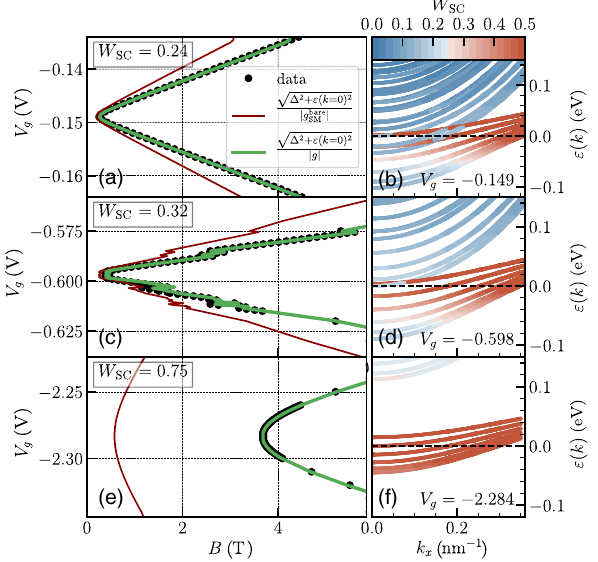
FIG. 13. Phase diagram (a),(c),(e) and band structure (b),(d),(f) in the vicinity of threshold gate voltages, corresponding to the − 0 . 15 (a),(b); V change in the number of subbands: V g ¼ g ¼ − 0 . 6 (c),(d); V − 2 . 3 (e),(f). Black dots in the left-hand panels g ¼ correspond to the numerically calculated phase boundary. Red and green curves in left-hand panels are the estimates obtained using the standard relation Eq. (9) and the bare SM ’ s g factor for the red curves and the renormalized g factor, Fig. 10, for the green